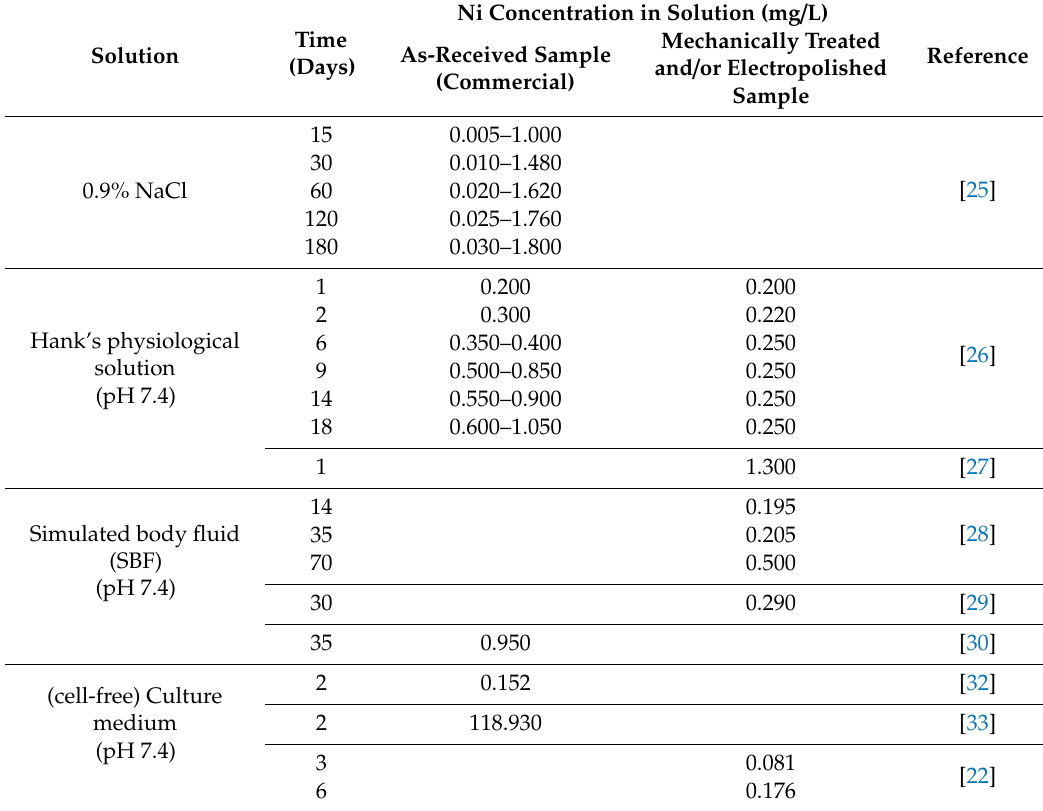
Table 5. Nickel concentrations in various solutions for various immersion times and nitinol samples types reported in the